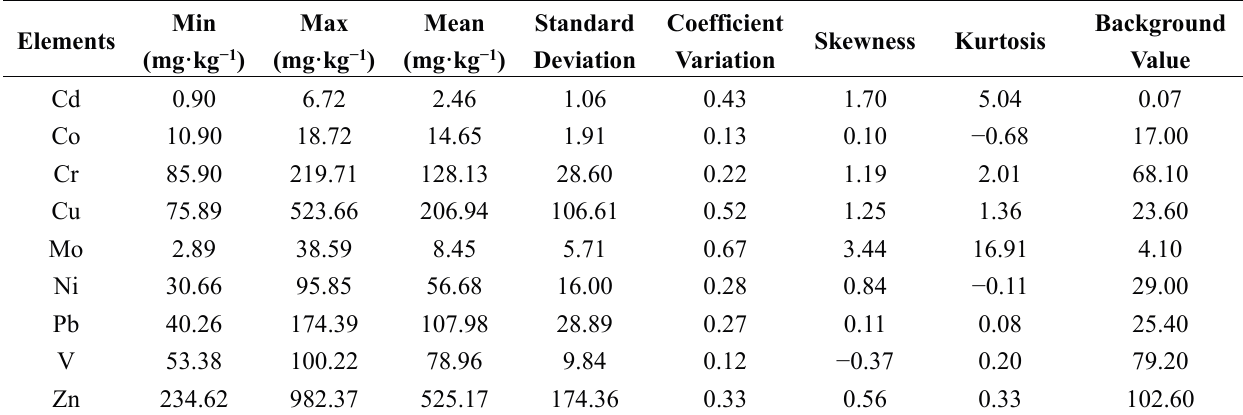
Table 3. Descriptive statistical analysis of heavy metals.